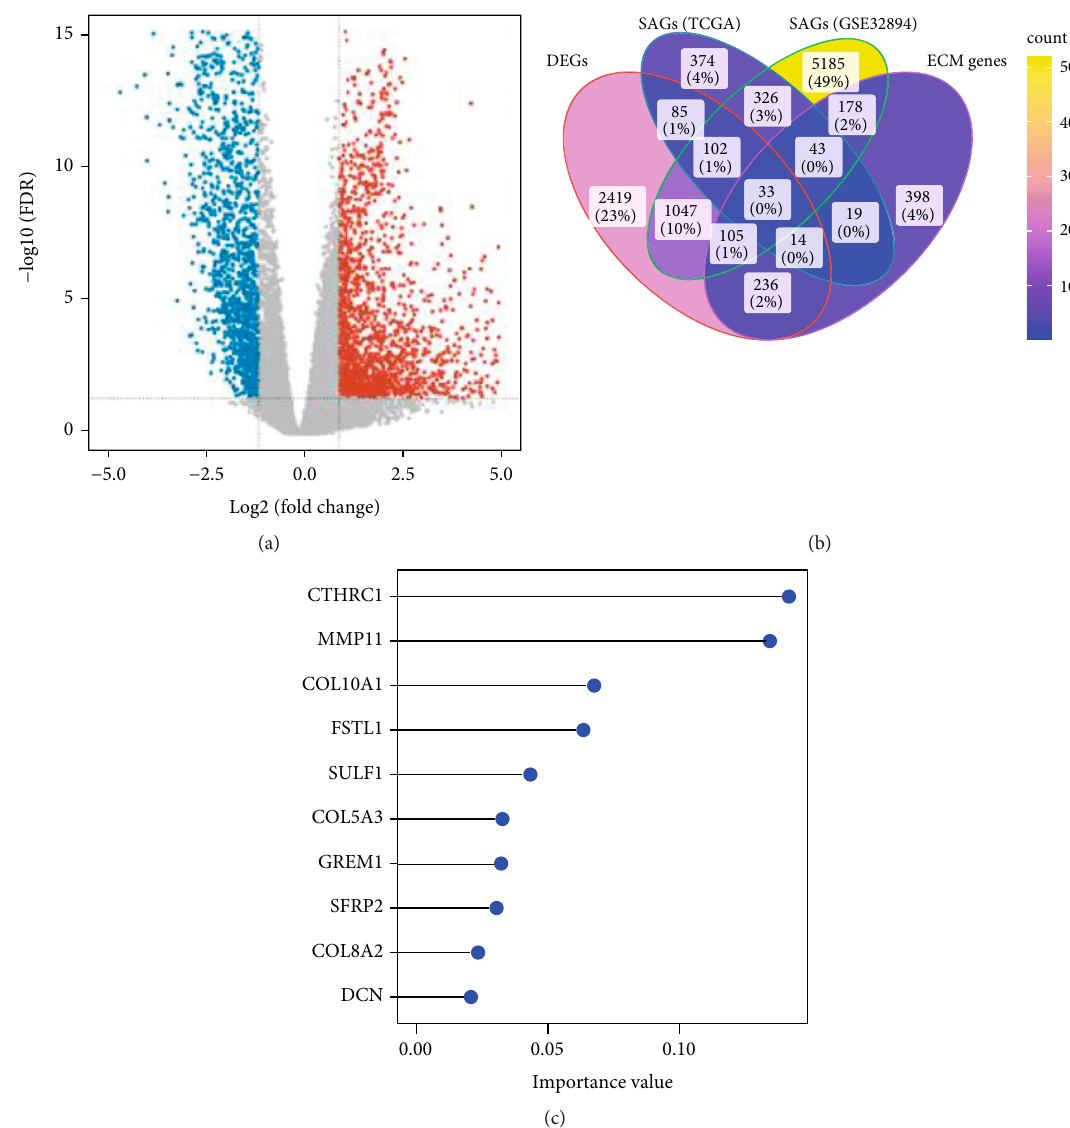
Figure 2: The identi fi cation of hub ECM-related genes. (a) Volcano plot for di ff erential gene expression between bladder cancer and normal bladder samples. Red represents upregulation in bladder cancer, blue represents downregulation in bladder cancer, and gray represents no change in expression. (b) Venn diagram of DEGs, SAGs (TCGA), SAGs (GSE32894), and ECM genes. (c) Random forest feature importance ranking for the top 10 ECM